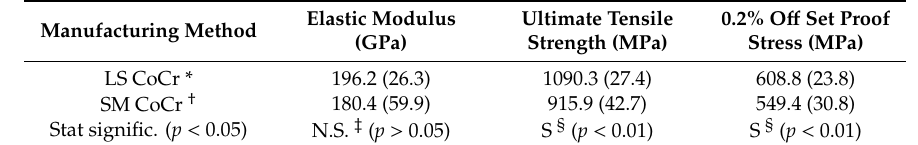
Table 3. Elastic modulus and hardness nanoindentation results for both manufacturing methods.